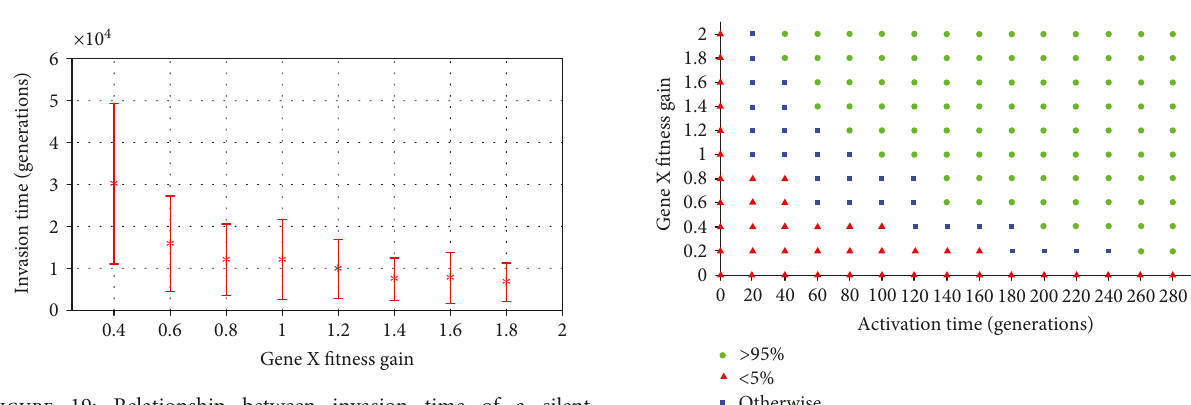
Figure 19: Relationship between invasion time of a silent cooperative gene and the magnitude of the gain in fi tness due to gene X mutations. For every value of gene X gain, the simulation has been run 100 times and the invasion time mean has been calculated. The vertical bars represent the standard deviation of the results.